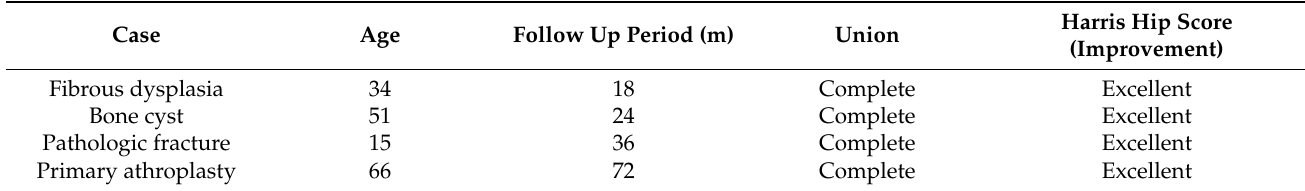
Table 1. Patients case histories.